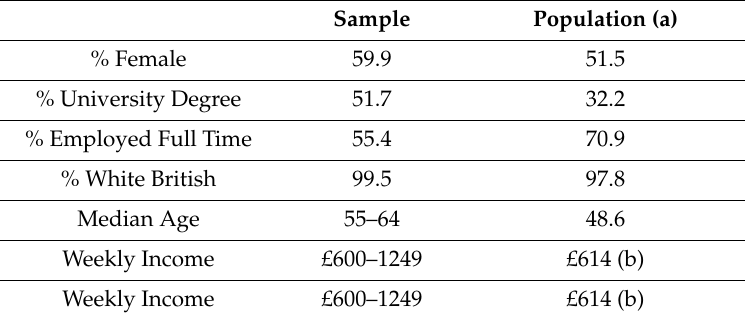
Table A1. Selected demographic characteristics of Preston New Road sample and